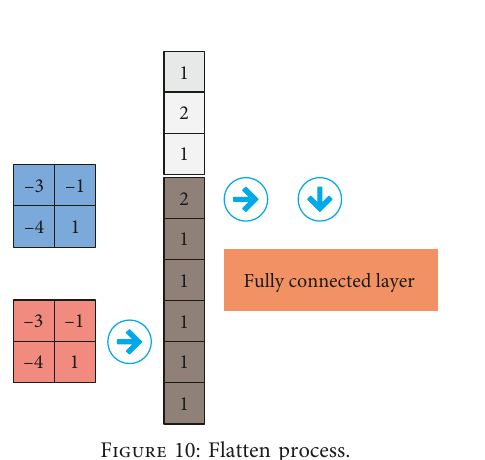
Figure 9: Zero-padding operation case.